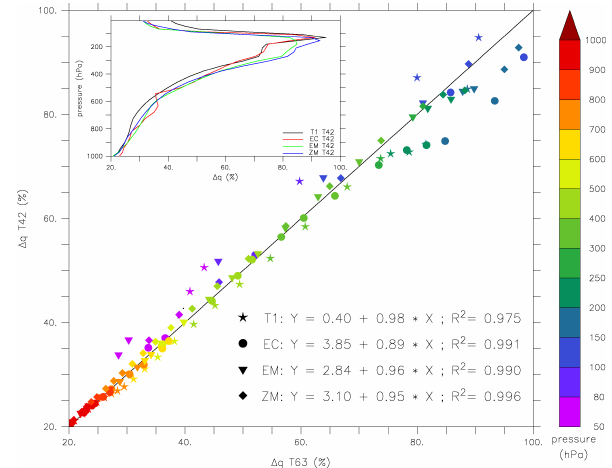
Figure 5. Correlation of the change of specific humidity 1q in % between the resolutions T63 (horizontal axis) and T42 (ver- tical axis) for the individual simulations distinguished by sym- bols (T1=star, EC=circle, EM=triangle and ZM=diamond) and colour coded with pressure altitude. The inner panel shows the in- crease in the specific humidity 1q in % for the coarser resolution (T42). The black line depicts the one-to-one